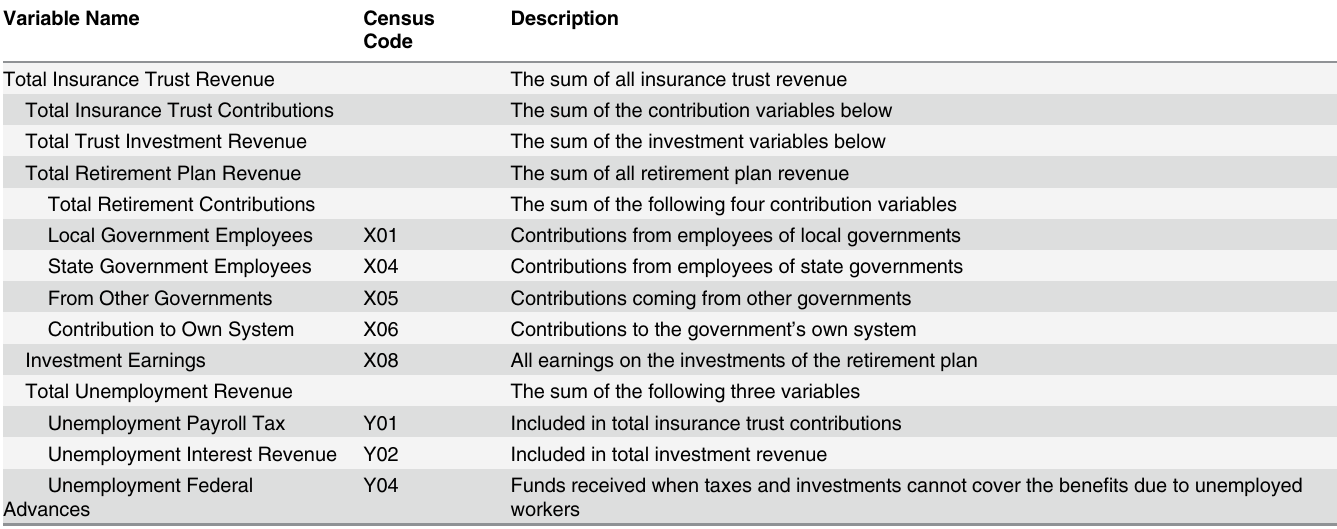
Table 6. Insurance Trust Revenue Variables.